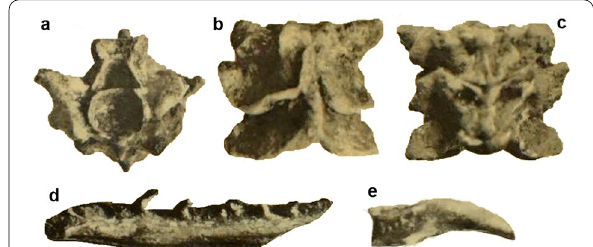
Fig. 111 Original lithograph of the type material of Paleryx cayluxi from imprecisely known localities in the Phosphorites du Quercy: a – c lectotype two articulated trunk vertebrae (unknown collection) in anterior ( a ), dorsal ( b ), and ventral ( c ) views; d paralectotype partial dentary (MNHN.F QU16327) in medial view; e paralectotype right pterygoid (MNHN.F QU16328) in ventral view. Modified from plates IV